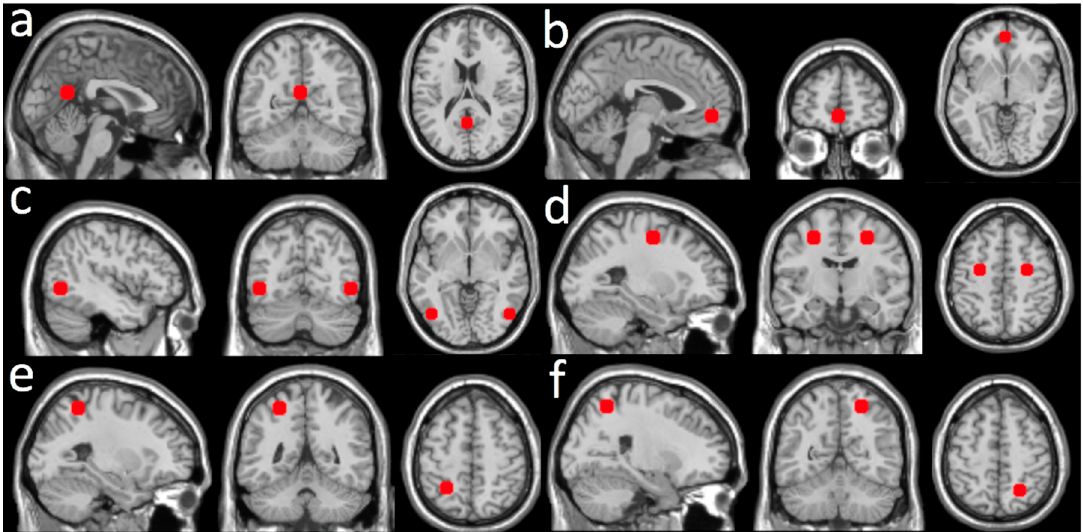
Figure 1. ROIs constructed from the seeds with the MNI coordinates listed: ( a ) posterior cingulate cortex (PCC, (1, − 55, 17) mm); ( b ) ventromedial prefrontal cortex (PFC, (0, 51, − 7) mm); ( c ) left and right middle temporal area (LMT, ( − 45, − 69, − 2) mm and RMT, (50, − 69, − 3) mm); ( d ) left and right frontal eye fields (LFE, ( − 25, − 8, 50) mm and RFE, (27, − 8, 50) mm); ( e ) left superior parietal lobule (LSPL, ( − 27, − 52, 57) mm); ( f ) right superior parietal lobule (RSPL, (24, − 56, 55) mm).